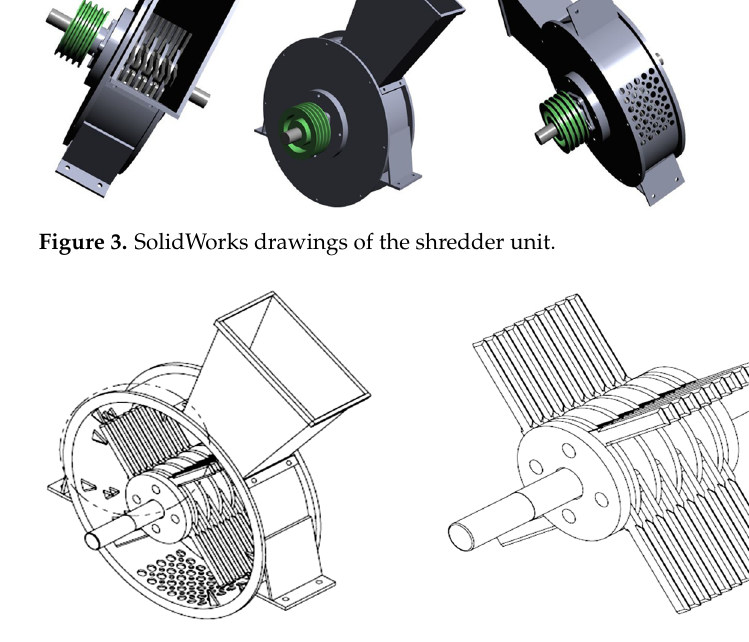
Figure 4. Shredder unit assembly drawings.